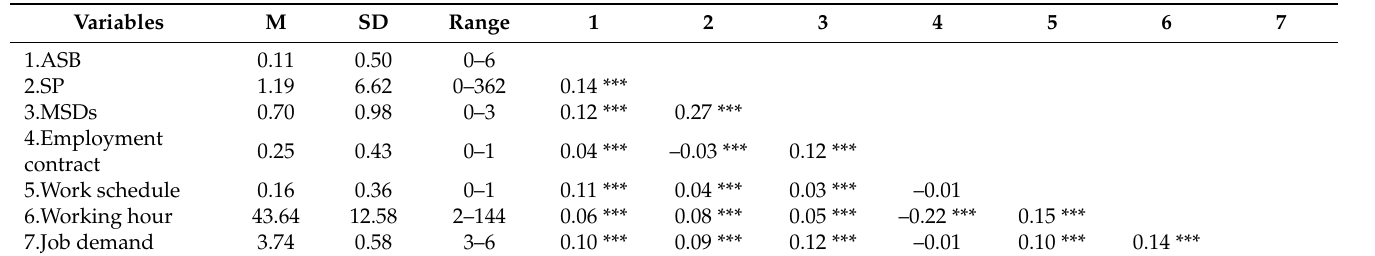
Table 2. Means, Standard deviation, and Correlations matrix of the predictor, mediator, moderators, and